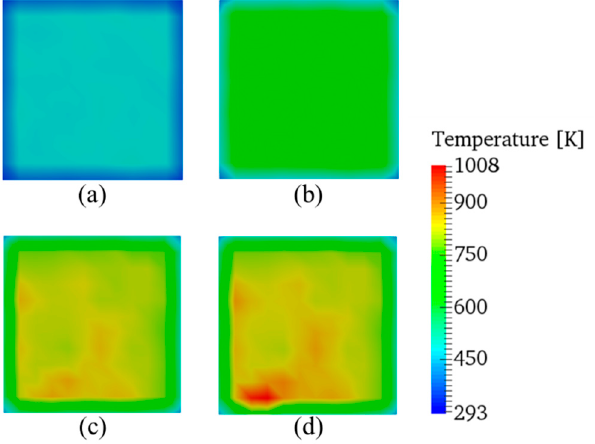
Figure 10. FDTD-calculated temperature distributions on the upper surface (x-y plane) of the MOV element at times of ( a ) 15 μ s, ( b ) 30 μ s, ( c ) 43.2 μ s, and ( d ) 45 μ s for a resistivity variation of ±10%.